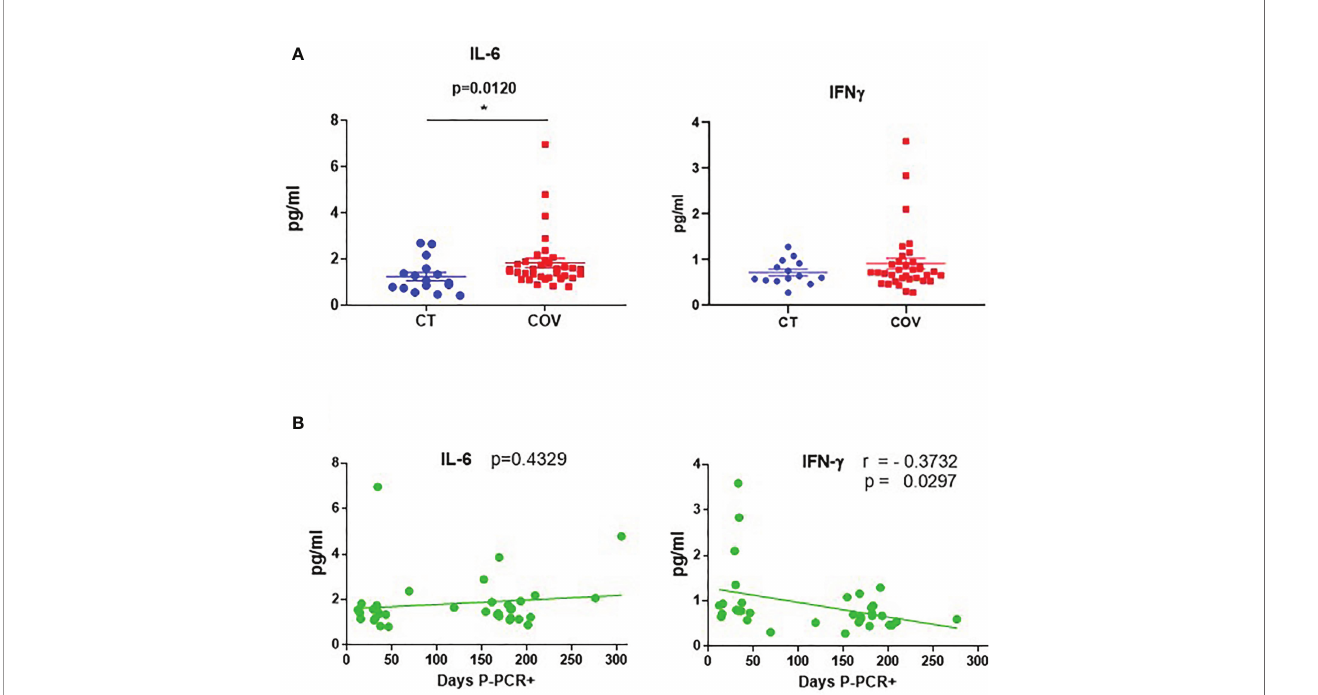
FIGURE 1 | Cytokine levels in recovered COVID-19 and healthy individuals. (A) Cytokine levels of IL-6 and IFN- g in healthy (CT) and recovered individuals (COV). Mean ± SEM. Pairwise comparisons were performed by a Mann – Whitney U-test corrected using the Benjamini – Hochberg method for multiple testing. (B) Correlation between days P-PCR+ and IL-6 and IFN- g levels. A linear regression curve is represented in each graph. Correlations were done using Spearman ’ s rank-order correlation test; r = Spearman ’ s rank correlation coef fi cient. P = p -value, adjusted by the Benjamini – Hochberg adjustment method for multiple testing. * p < 0.05. Each symbol corresponds to an